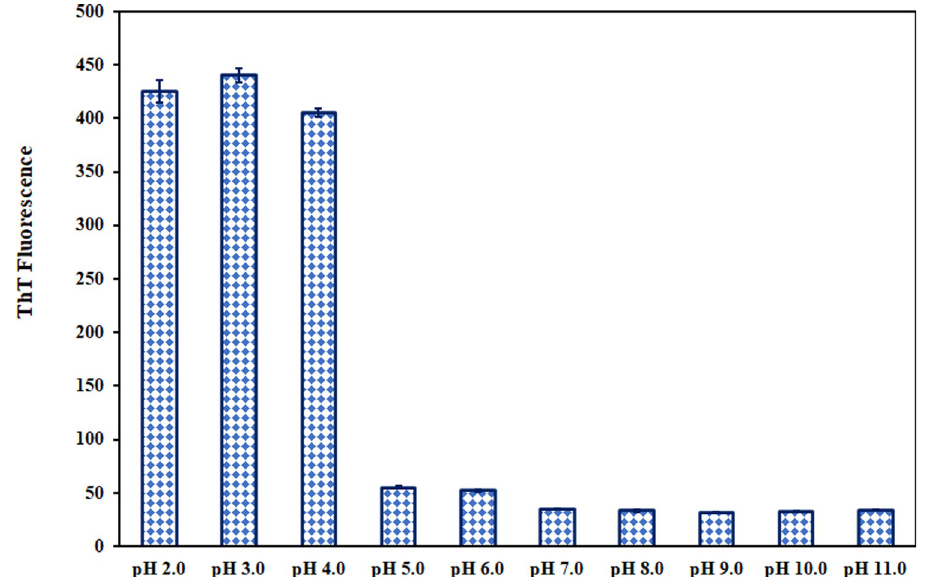
Fig 4. Aggregates characterization by ThT fluorescence. ThT fluorescence intensity was plotted as a function of pH